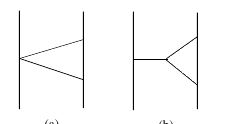
Figure 1 . The single graph topology at or- der G : one-graviton exchange with no self- interaction.